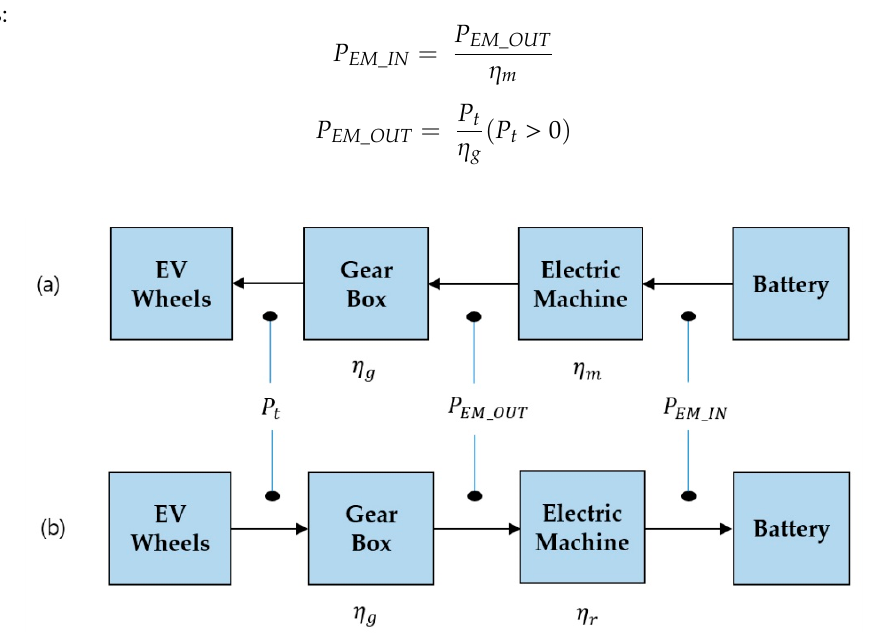
Figure 12. Energy conversion chain of each modes; ( a ) motoring mode, ( b ) regenerative braking mode.